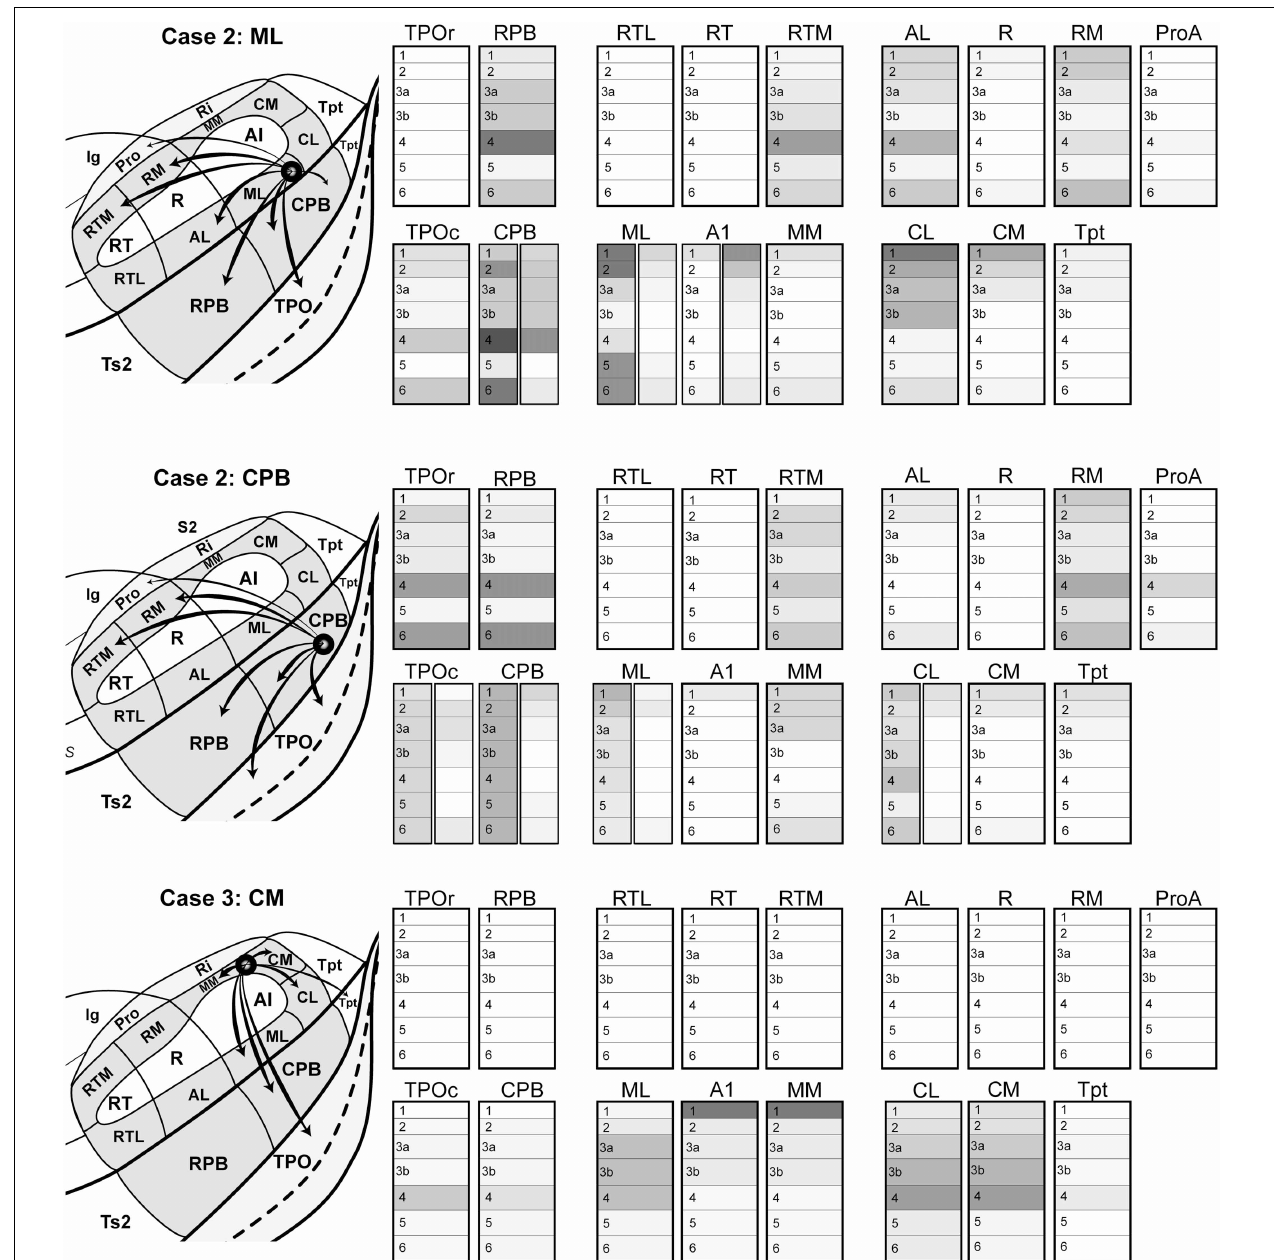
FIGURE 10 | Summary of areal and laminar projection profiles from Cases 2 and 3, derived from Figures 4–9 and Supplementary Table 2. Left , schematics of the auditory cortex and TPO showing the principal feedforward projections from the location of the injection site in each case: Case 2 ML , FR injection into caudal-lateral ML; Case 2 CPB , BDA injection into caudal-ventral CPB; Case 3 CM , BDA injection into rostral-medial